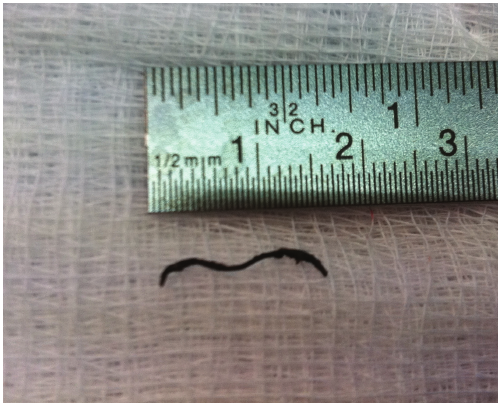
Figure 2: The foreign body which was a stapler